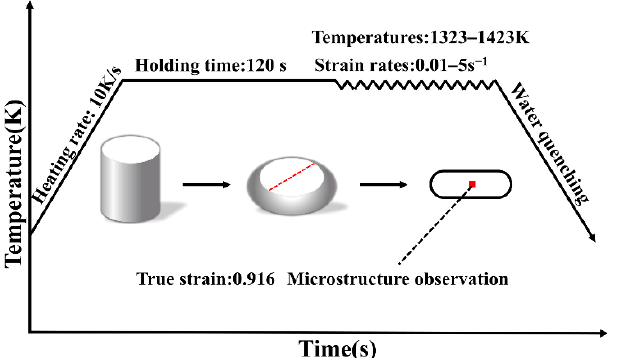
Figure 1. The diagram illustration of Ni-Cr-Co-based superalloy during isothermal hot compression